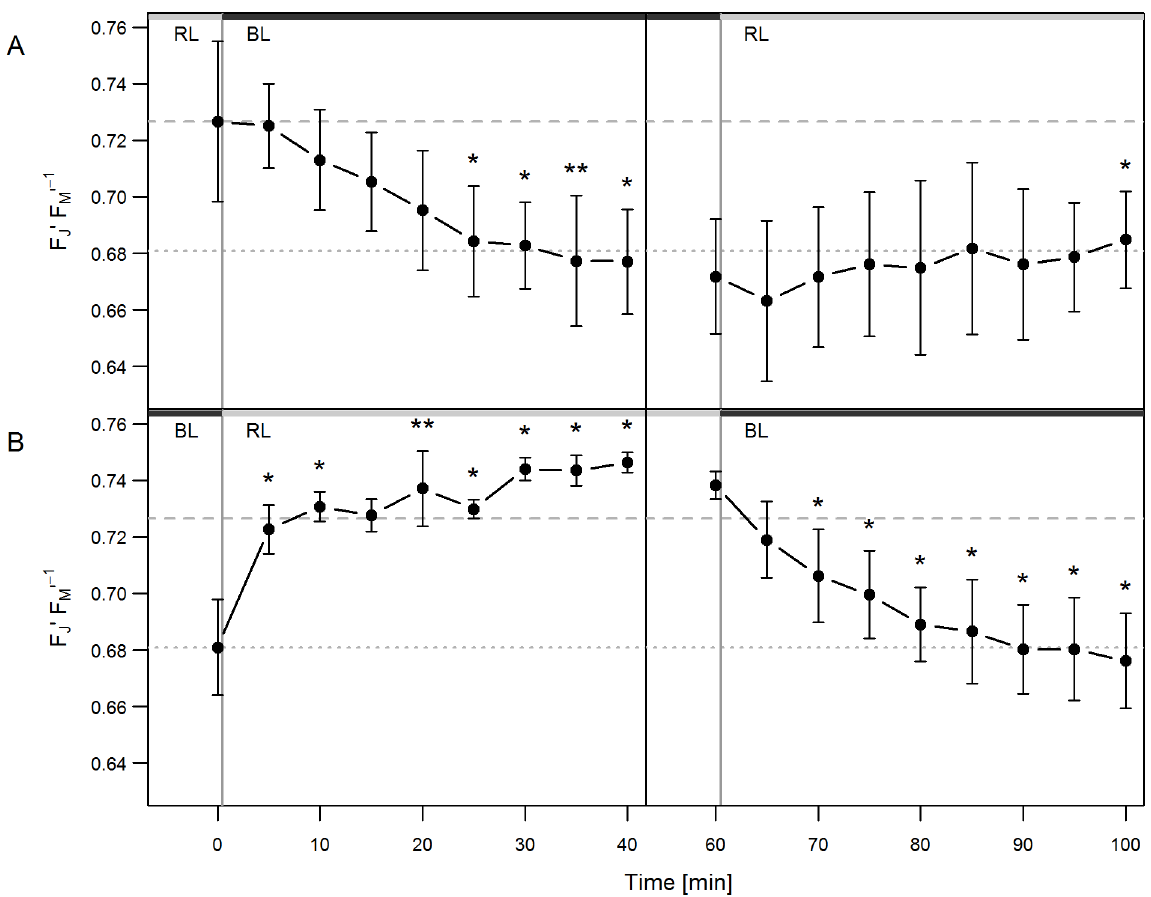
Figure 2. Fast fluorescence induction kinetics. The changes of the J Level of fast fluorescence induction kinetics (F J 9 F M 9 2 1 ) were recorded during the light quality changes. (A) RL to BL shift of a RL adapted culture (0–40 min) followed by a light shift back to RL (60–100 min) (B) BL to RL shift of a BL adapted culture (0–40 min) followed by a light shift back to BL (60–100 min). The horizontal lines show the J level of BL (dotted) and RL (dashed) adapted cultures. The asterisks depict the p-values of the respective data point compared to t 0 min (0–40 min) or to t 60 min (60–100 min). n=3. The exact values are specified in Table S2.